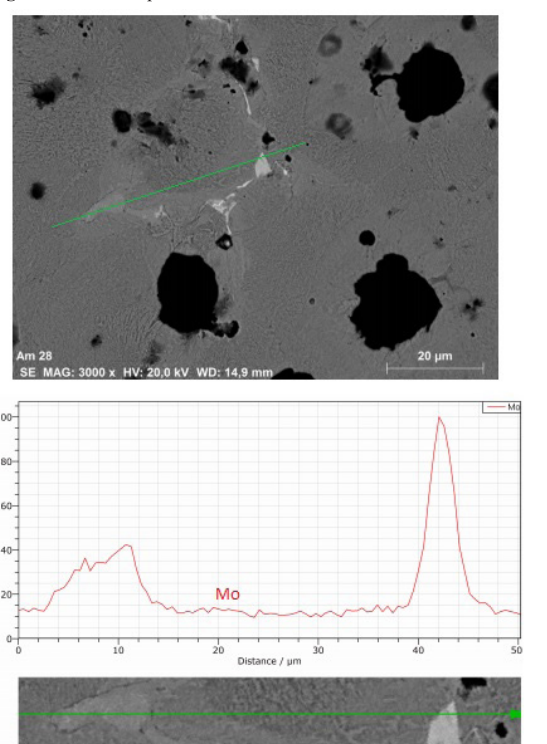
Figure 26. Cr EDS